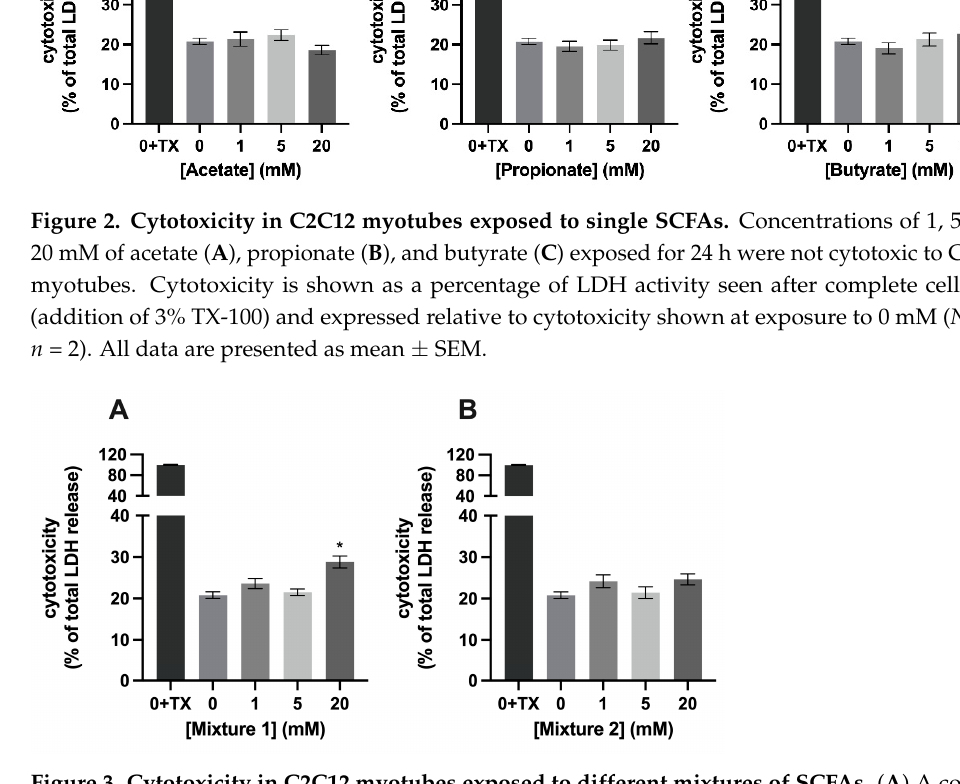
Figure 3. Cytotoxicity in C2C12 myotubes exposed to different mixtures of SCFAs. ( A ) A concen ‐ tration of 20 mM of mixture 1 exposed for 24 h on C2C12 myotubes increased cytotoxic compared to 0 mM SCFA. ( B ) Mixture 2 was not cytotoxic to C2C12 myotubes at concentrations of 0–20 mM exposed for 24 h. Cytotoxicity is shown as a percentage of LDH activity seen after complete cell lysis (addition of 3% TX ‐ 100) and expressed relative to cytotoxicity shown at exposure to 0 mM (N = 3; n = 2). All data are presented as mean ± SEM. * p < 0.001 compared to 0 mM SCFA exposure. 3.2. Exposure to 5 mM of Mixture 1 Increased Glucose Uptake in C2C12 Myotubes